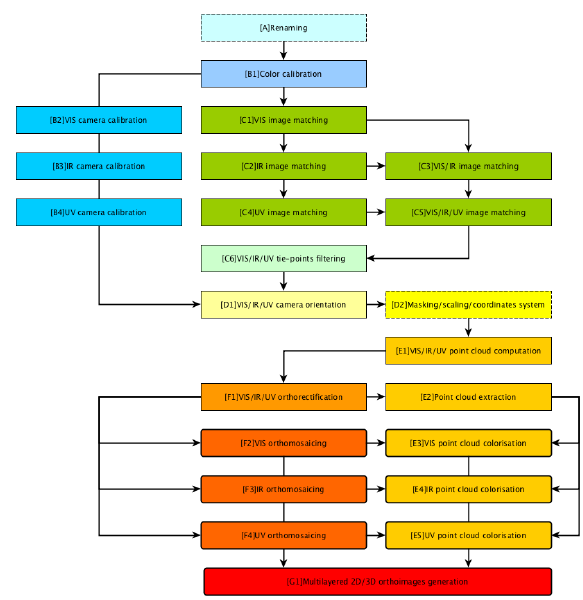
Figure 8: Diagram of the pipeline described